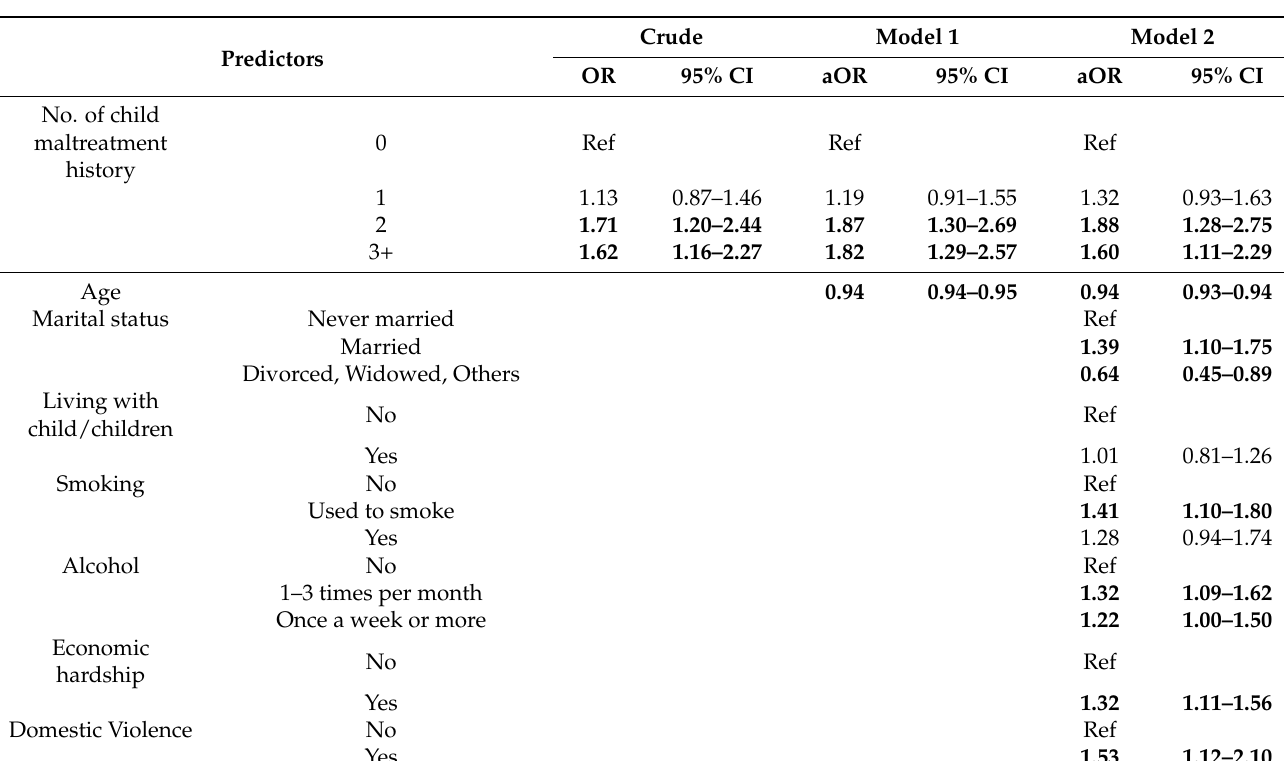
Table 3. Bivariate and multivariate associations between the number of types of childhood maltreatment and premenstrual